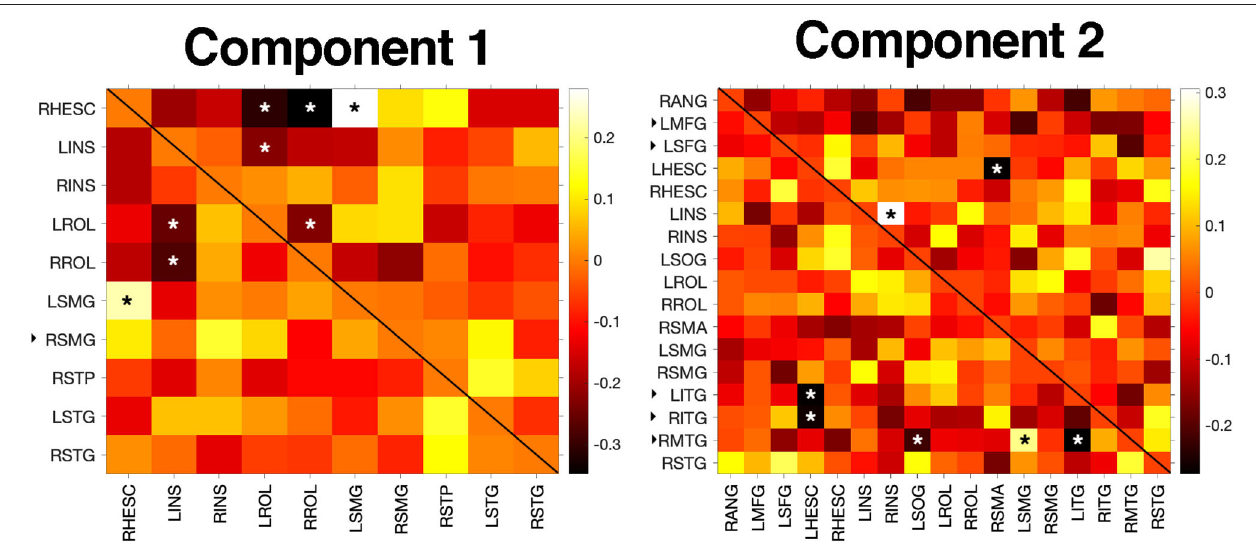
FIGURE 3 | Correlation results. BRIEF-A and CAD scores were not correlated with centralities of significant NBS edges but were associated with centralities of several alternate edges connecting significant NBS nodes ( p < 0.05). In the heatmaps, significant correlations with CAD are denoted with an asterisk in the upper triangle while correlations with BRIEF-A are denoted in the lower triangle. Colorbar indicates correlation coefficient. The black, right facing triangle next to a node label indicates a non-hub. All other nodes were hubs. L/RHESC, right Heschl’s gyrus; L/RINS, left/right insula; L/RROL, left/right Rolandic operculum; L/RSMG, left/right supramarginal gyrus; RSTP, right superior temporal pole; L/RSTG, left/right superior temporal gyrus; RANG, right angular gyrus; LMFG, left middle frontal gyrus; LSFG, left superior frontal gyrus; LSOG, left superior occipital gyrus; RSMA, right supplementary motor area; L/RITG, left/right inferior temporal gyrus; RMTG, right middle temporal gyrus; RSTG, right superior temporal